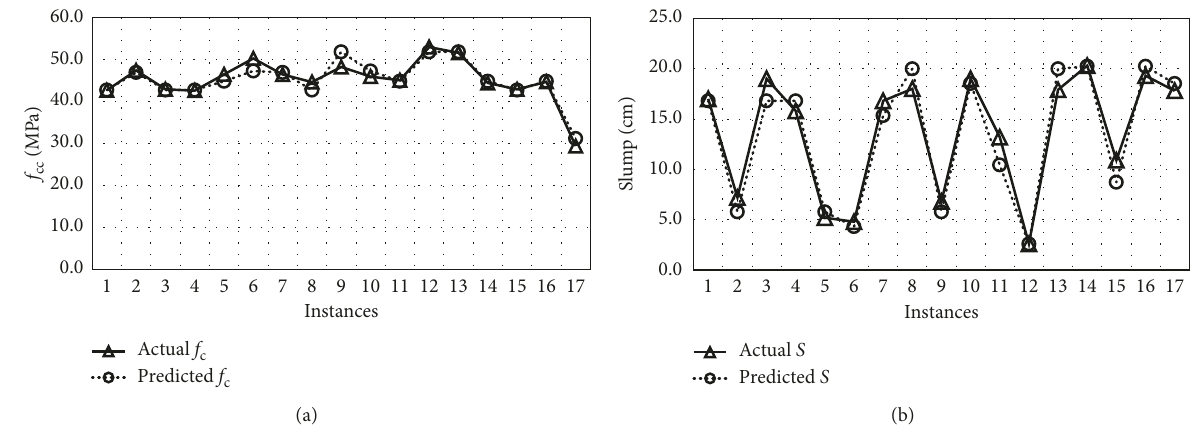
Figure 5: Comparison between actual and predicted values of f